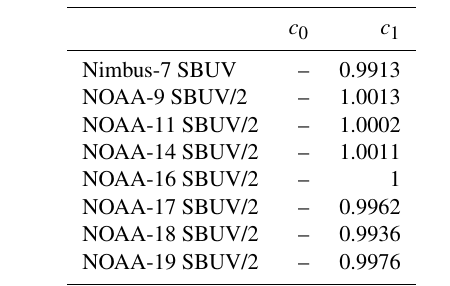
Table 1. Gain c 1 and offset c 0 values used to make adjustments to observed intensities using the linear equation I adj = c 1 · I original + c 0 .